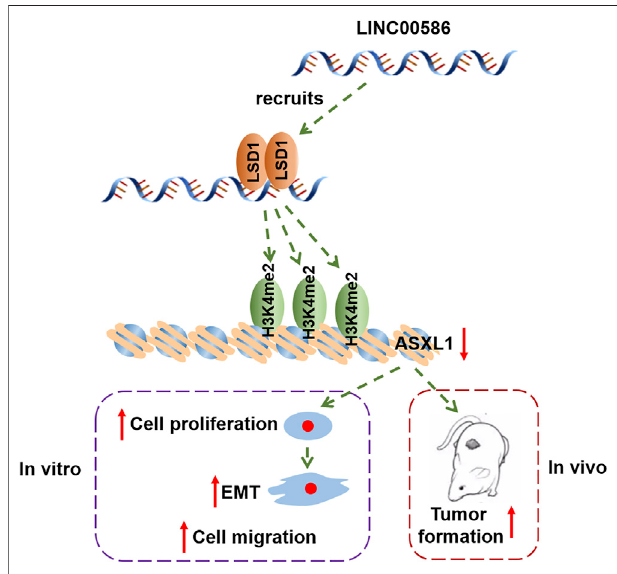
FIGURE 6 | The graphical summary of the mechanism of LINC00586 in regulating CRC progression. LINC00586 epigenetically silenced ASXL1 transcription through LSD1-mediated H3K4me2 demethylation, thereby leading to the development and progression of